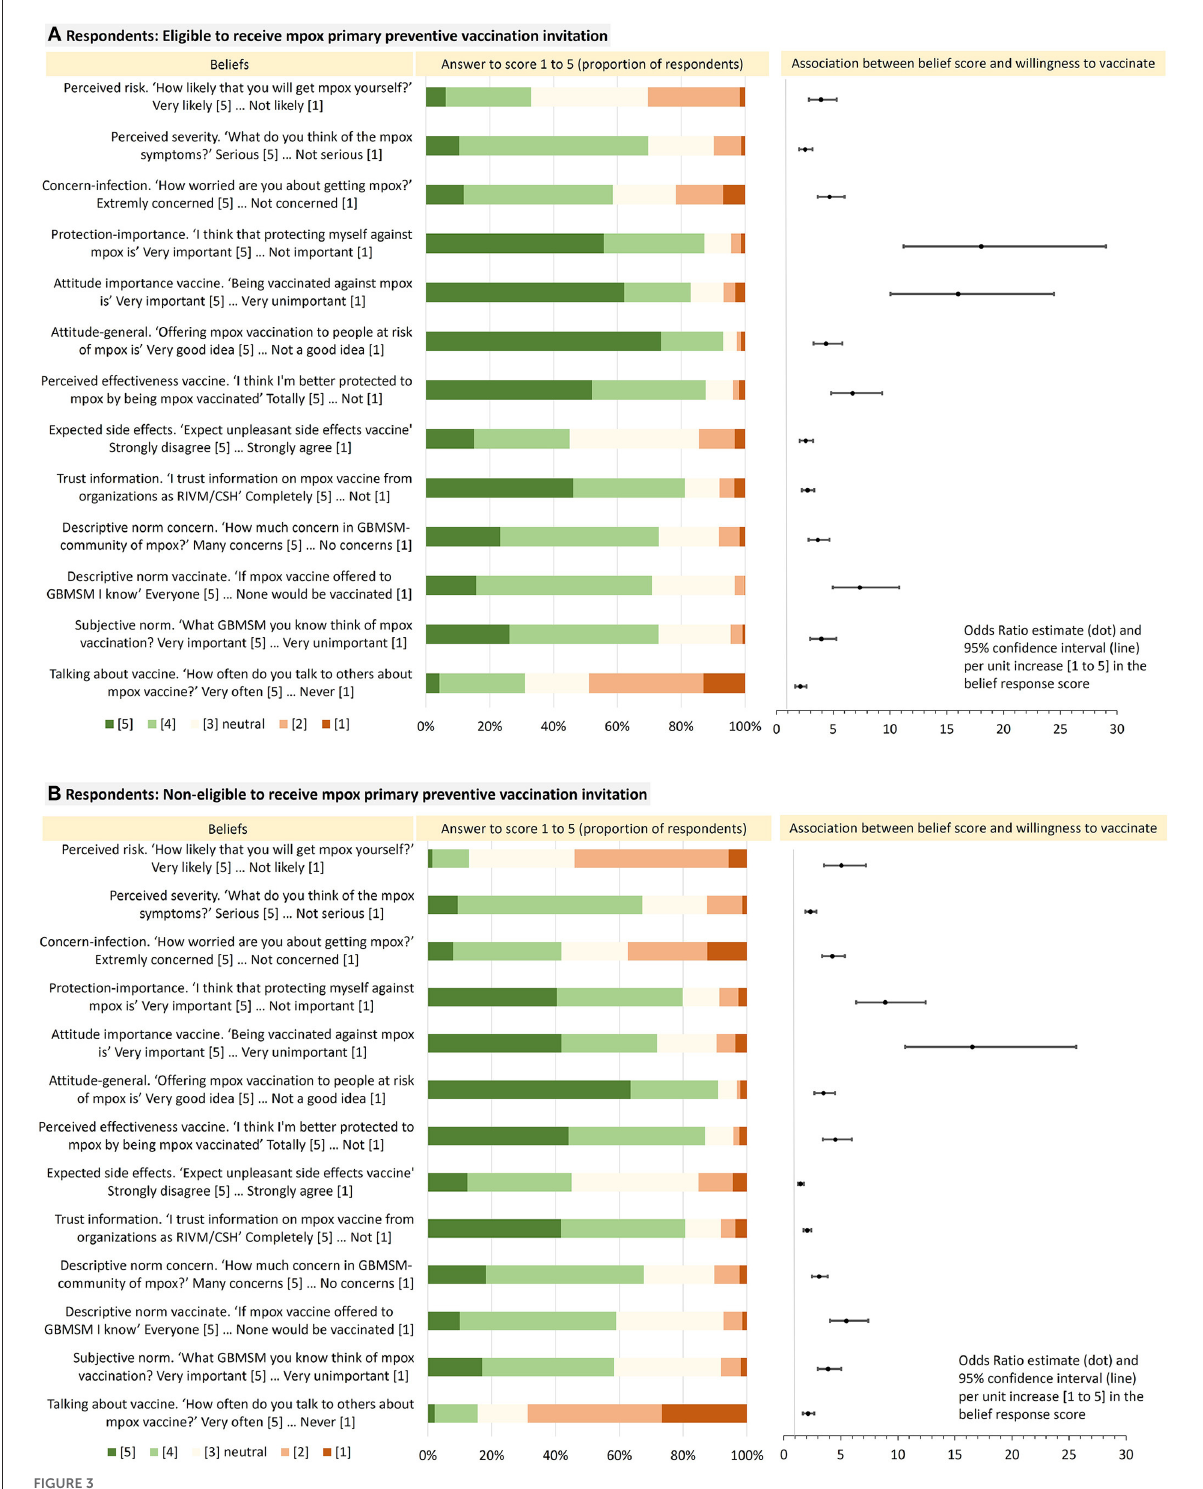
FIGURE3 Distribution of responses to belief-statements in respondents who are eligible to receive PPV-invitation and those non-eligible (left) , and the odds for each of these beliefs (right) for their association with being willing (certainly or likely) to accept mpox vaccination when offered (compared to not willing/being neutral), in multivariable logistic regression analyses, mpox unvaccinated GBMSM/TGP participating in Dutch online mpox-survey (22 July-5 Sept